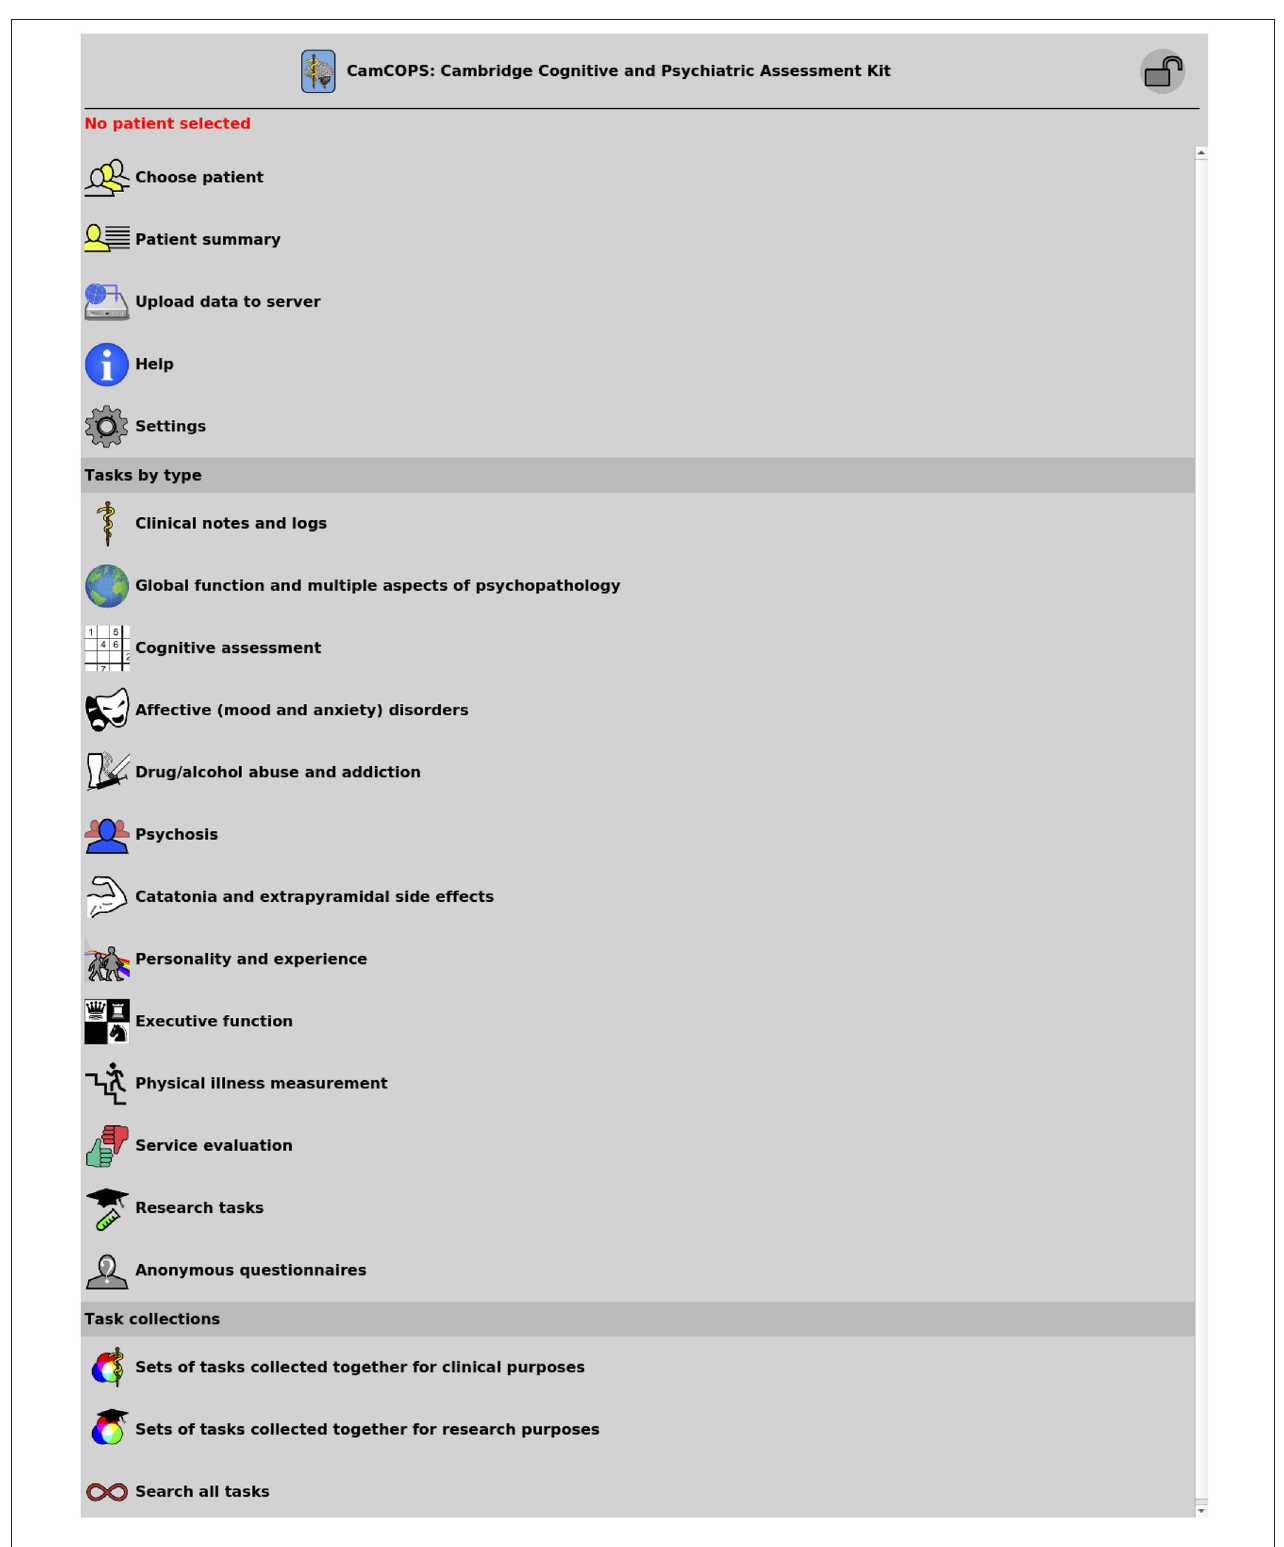
FIGURE 2 | The main menu of the CamCOPS